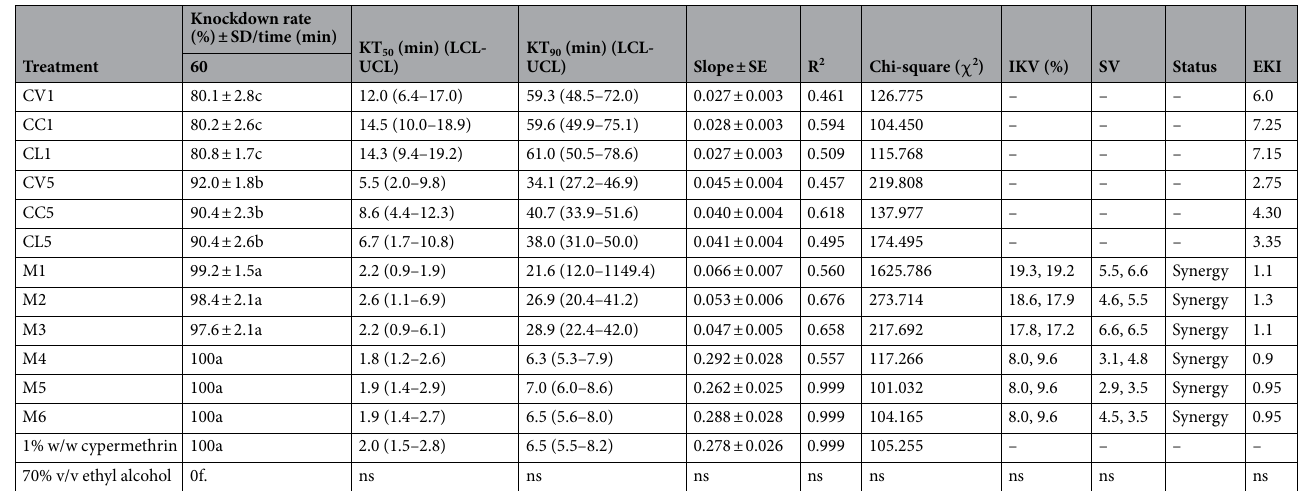
Table 3. Knockdown rates and KT 50 time of essential oils from C . verum , C . cassia and C . loureiroi and their combinations against females of Ae . albopictus . Mean percentage knockdown rates in each column followed by a different letter are significantly different (one way ANOVA and Duncan’s multiple range test, P < 0.05). KT 50 50% knockdown time, R 2 regression coefficient, LCL lower confidence limit, UCL upper confidence limit, IKV (%) Increasing Knockdown Value, EKI Effective Knockdown Index, SV Synergistic Value, ns not significant. Treatment codes are defined in Table